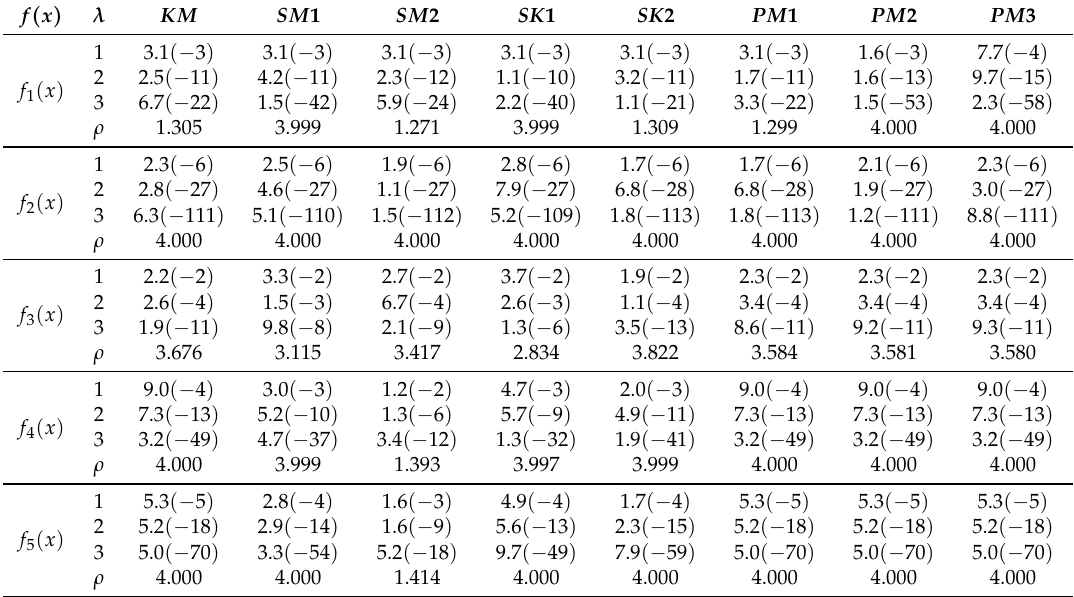
Table 1. Absolute errors between iterations ( | x λ + 1 − x λ | ) among different iteration functions.